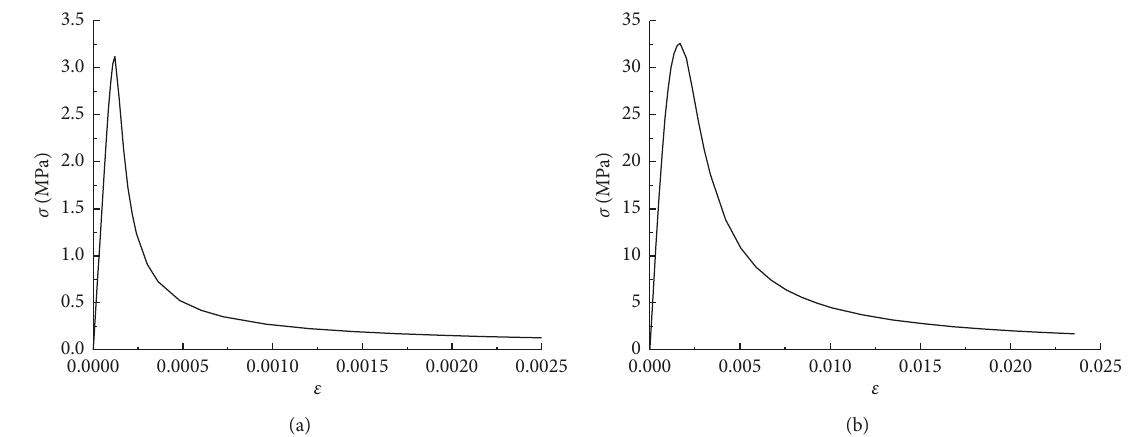
Figure 14: Stress-strain curves of the filled concrete in the simulation. The behavior for filled concrete in tension (a) and in compression